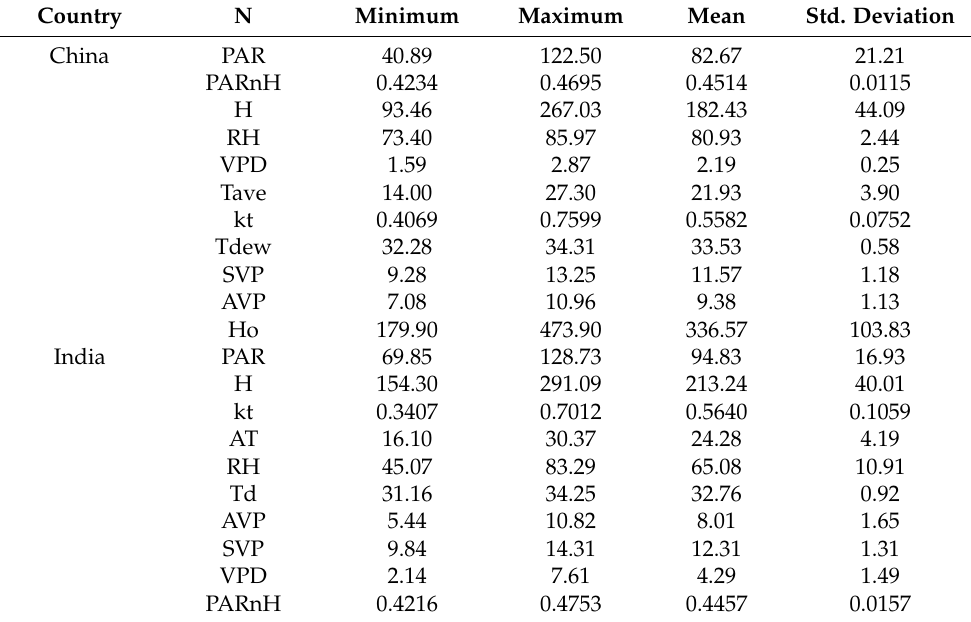
Table 1. Descriptive statistics of the input and output parameters in China and India. Country N Minimum Maximum Mean Std.